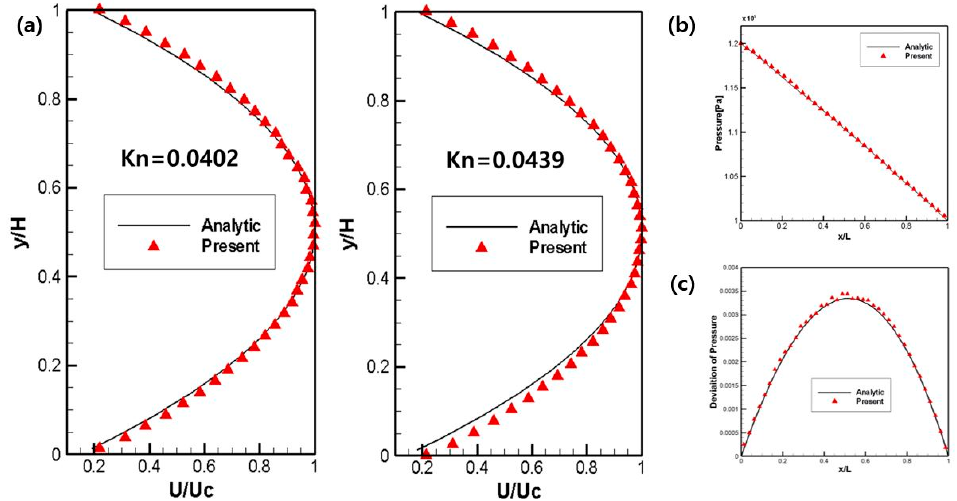
Figure 2. ( a ) Velocity pro fi les for microchannel fl ow. ( b ) Pressure pro fi le ( 𝐾𝑛 = 0.0439) of microchan- nel fl ow. ( c ) Deviation in the pressure ( 𝐾𝑛 = 0.0439) of microchannel fl ow. flow. ( c ) Deviation in the pressure ( Kn = 0.0439) of microchannel